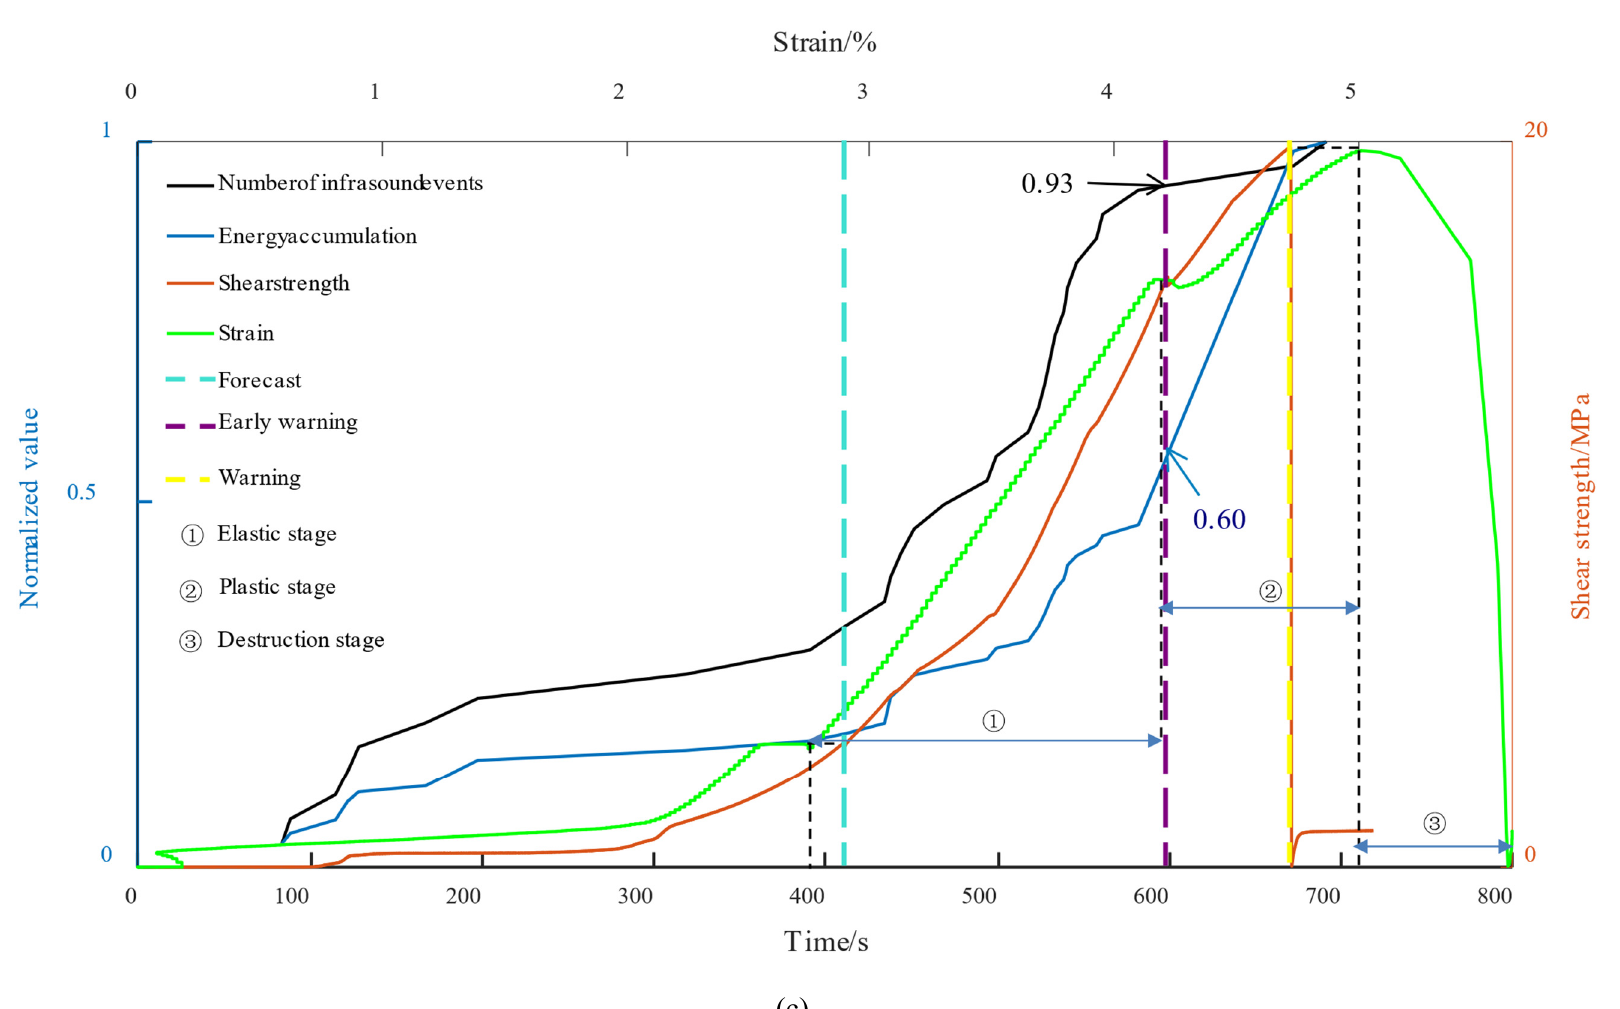
Figure 6. Relationships of normalized infrasound event rate, normalized energy accumulation rate, and shear force-time diagram of typical samples. ( a ) Sample a1-1; ( b ) sample b2; ( c ) sample c3.